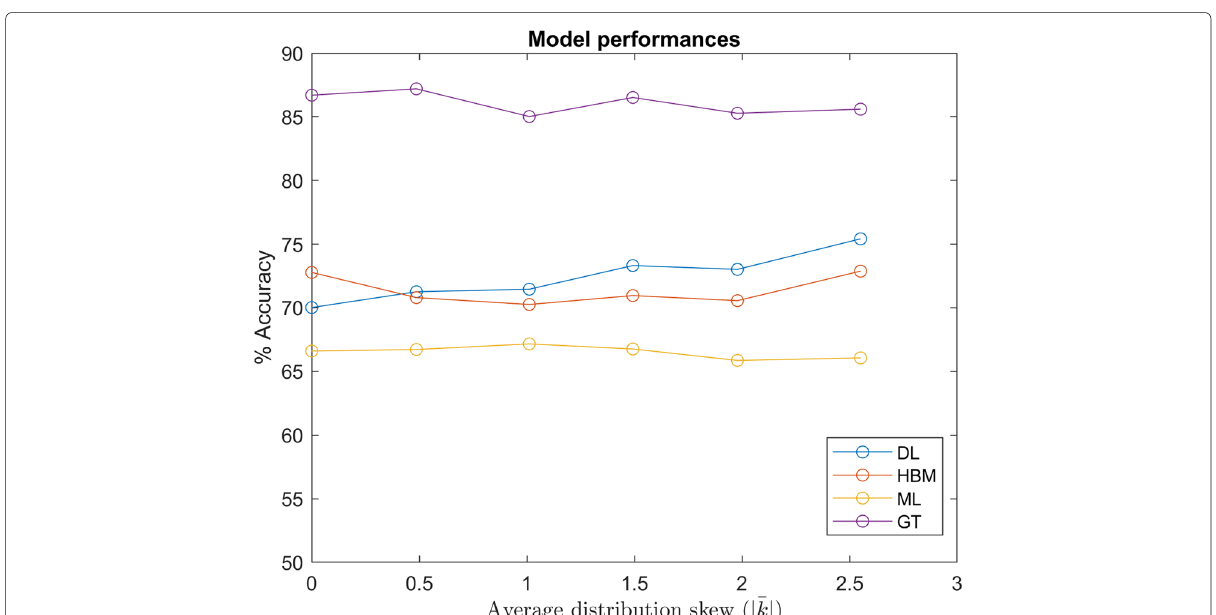
Fig. 11 Model Performances: Comparison of model performances (DL trained with 2,000 participants involved) over datasets with various underlying distributions of w , denoted by the approximate average of absolute shape factors k ( denotes the predictive model in which the exact w for each participant is known